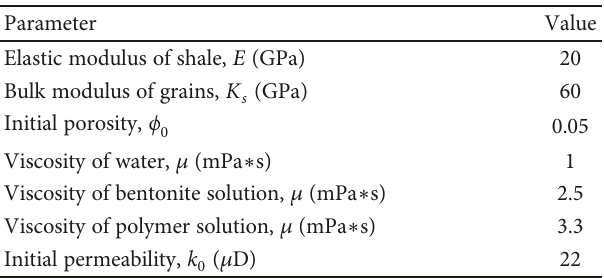
Figure 4: Comparison of the numerical results by our model with the experimental data by Yoo et al. [12]. Table 3: Computational parameters of shale.